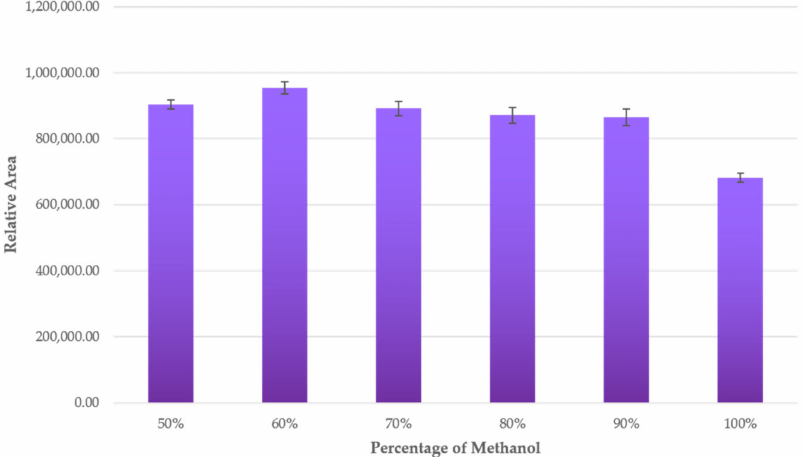
Figure 3. Anthocyanins’ relative area according to different methanol percentages in the extraction solvent ( n = 3).